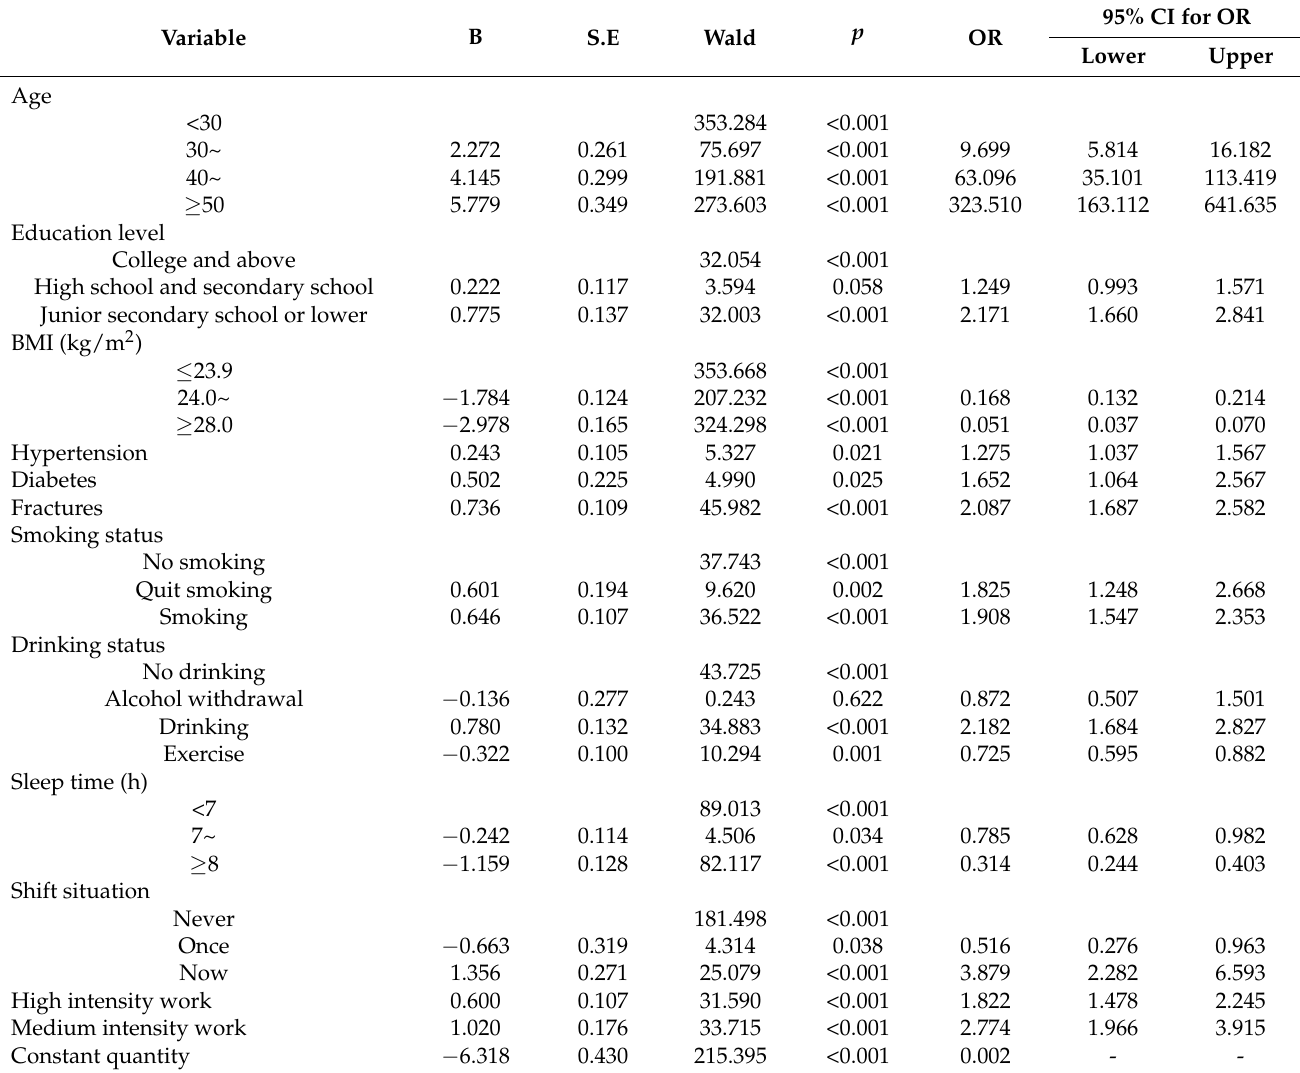
Table 6. Logistic regression analysis of the influencing factors of abnormal bone mineral density.